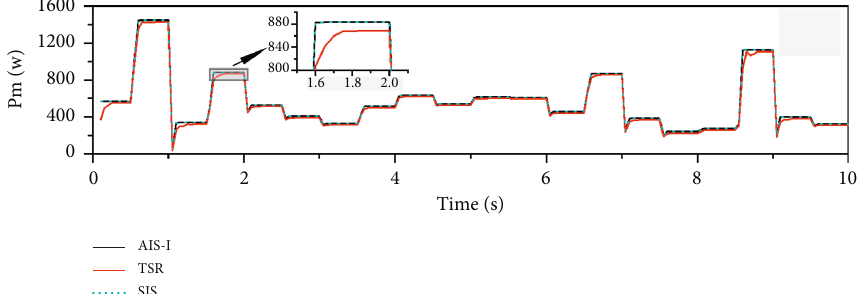
Figure 12: The output power response based on different methods.